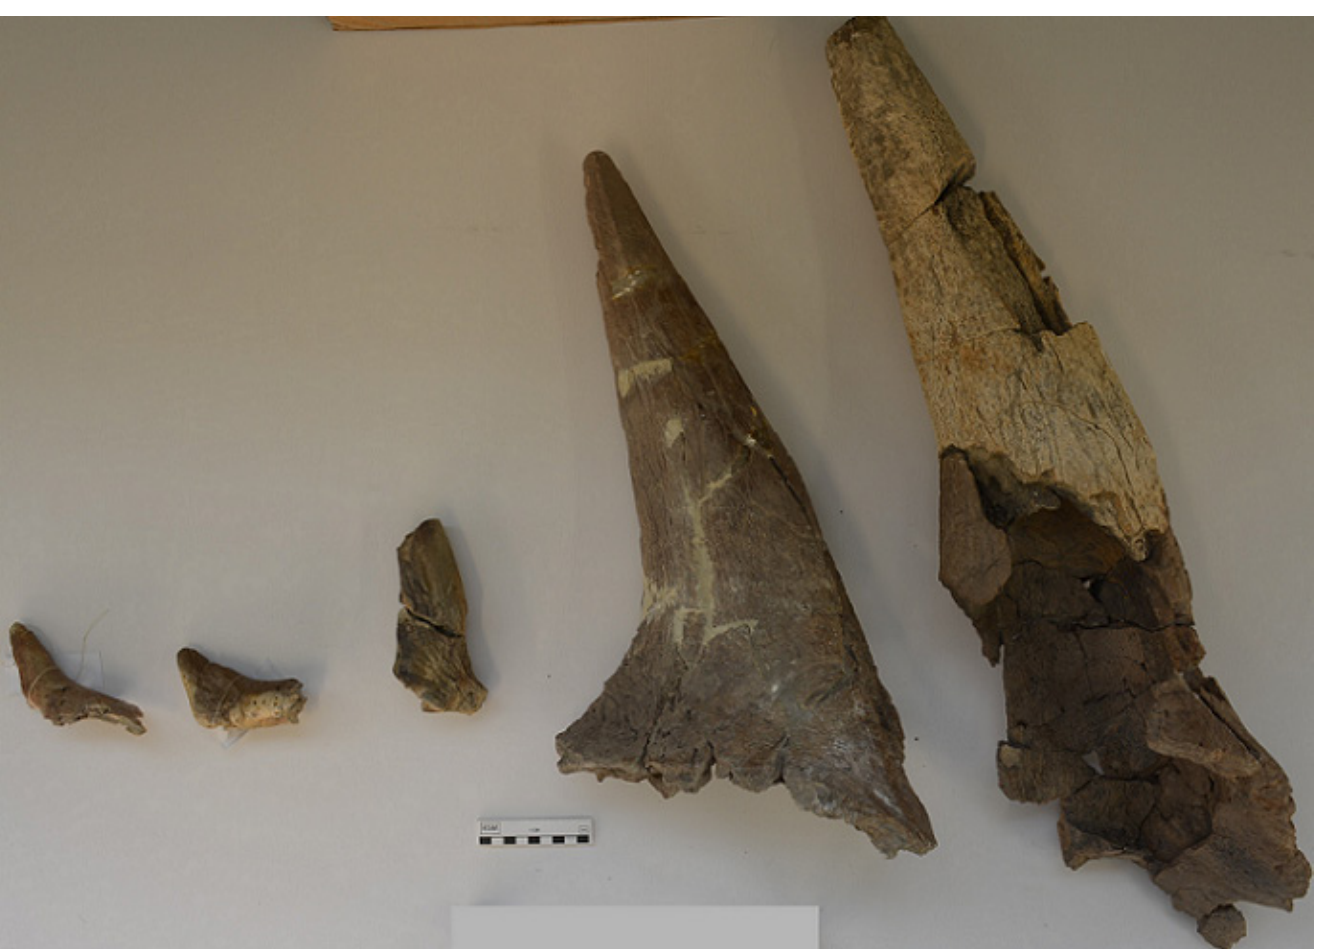
Figure 1. A growth series of right supraorbital horncores from Triceratops specimens collected from Saskatchewan. Specimens, from left to right, are RSM P2623.1, RSM P2299.1, RSM P3228.1, RSM P2982.1 and RSM